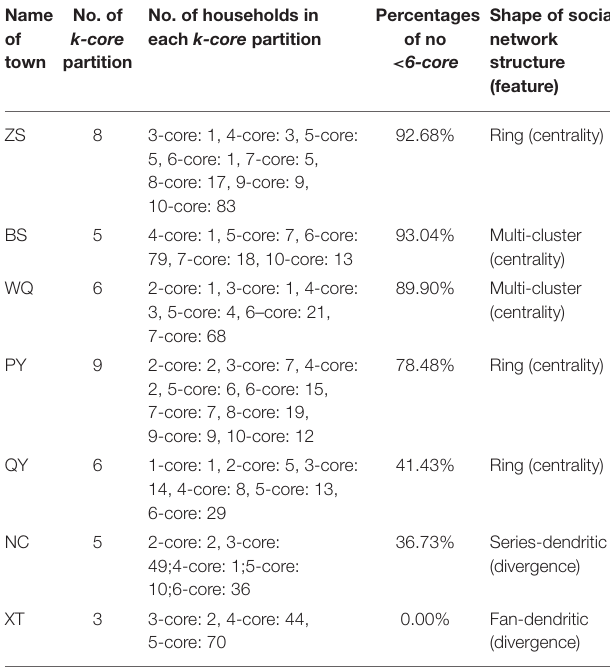
TABLE 2 | Results of the k-core analysis of seven historical